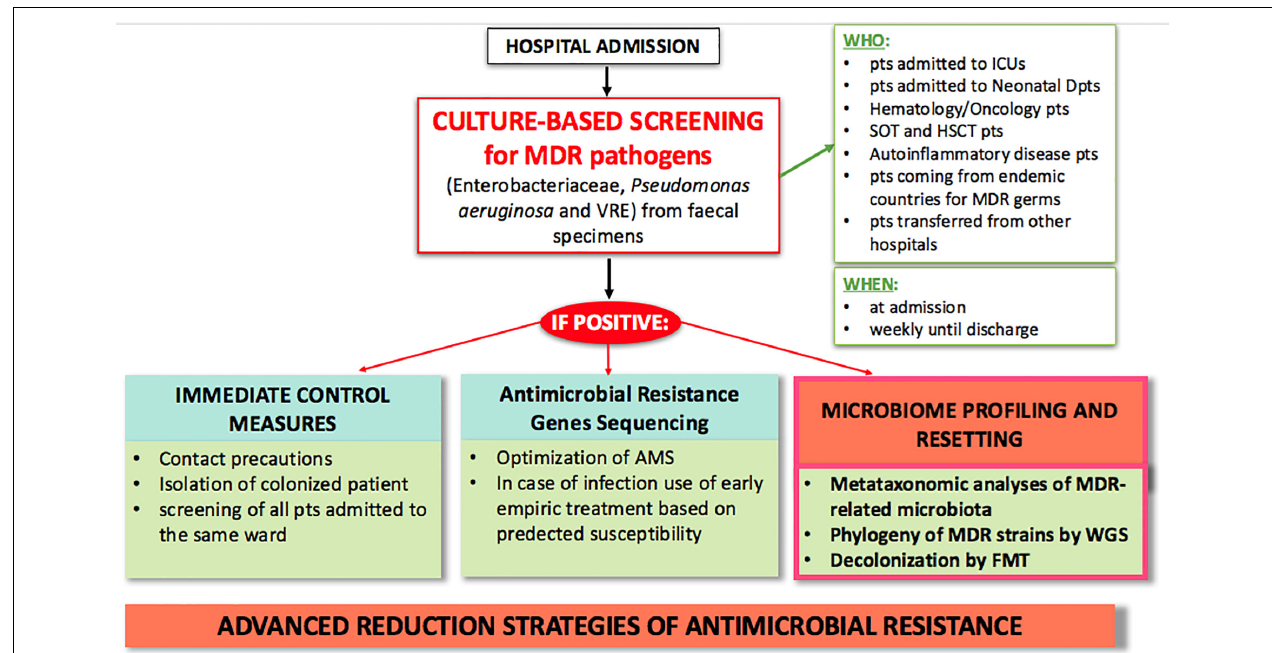
FIGURE 2 | Proposed model of advanced clinical and laboratory stewardship for MDR pathogen screening in hospital settings. AMS, antimicrobial stewardship; FMT, fecal microbiota transplantation; HSCT, hematopoietic stem cell transplantation; ICU, intensive care unit; MDR, multi-drug resistant; pts, patients; SOT, solid organ transplant; WGS, whole genome